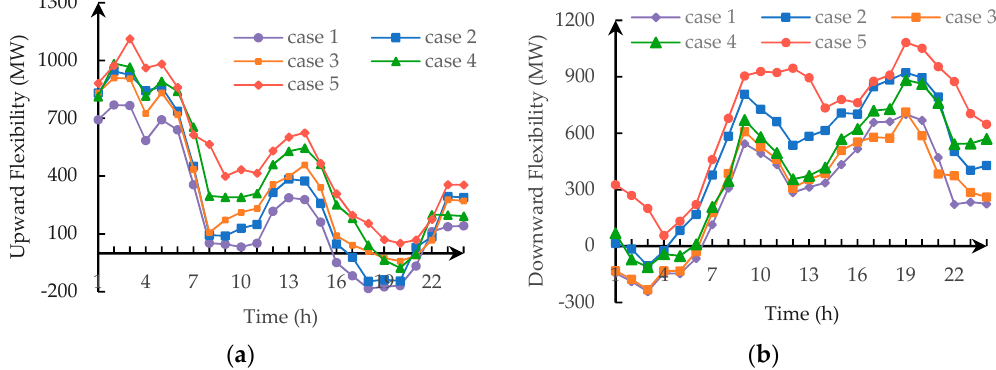
Figure 3. Different cases of flexibility margin: ( a ) upward-regulation flexibility of system in different cases; ( b ) downward-regulation flexibility of system in different cases.